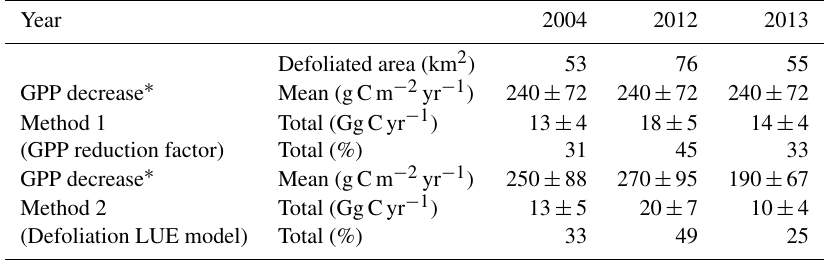
Table 2. Defoliated area (km 2 ) and annual reduction in GPP ∗ (GgCyr − 1 ) for the 3 years with insect defoliation since the year 2000. The total area with forest cover is 100km 2 .